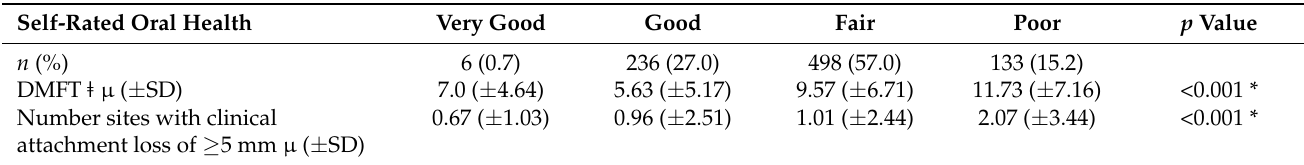
Table 2. Distribution of clinical oral health variables according to self-rated oral health.